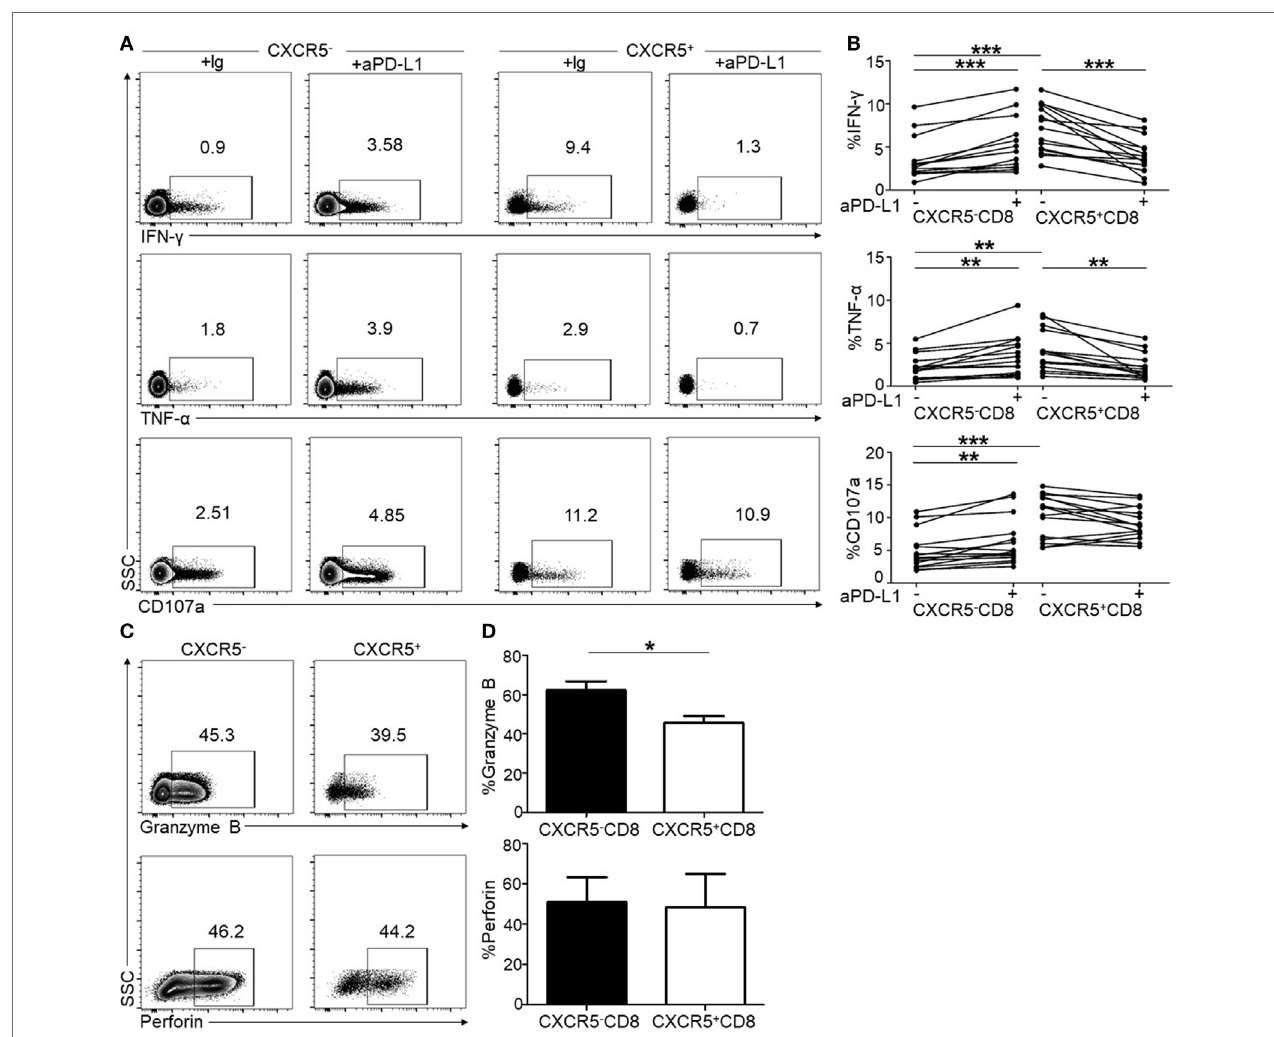
FigUre 4 | Programmed cell death 1 (PD-1) blockade shows opposite effects on CXCR5 − and CXCR5 + CD8 + T cells in peripheral lymphocytes. Peripheral blood mononuclear cells (PBMCs) from HIV-infected patients were stimulated for 8 h using HIV overlapping peptides with or without anti-PD-L1. The flow cytometric plots show intracellular IFN- γ (a) , TNF- α (a) , and CD107a (a) staining on CXCR5 − and CXCR5 + CD8 + T cells populations, respectively. (B) Statistical analysis of intracellular IFN- γ , TNF- α , and CD107a staining of CXCR5 − and CXCR5 + CD8 + T cells (a paired t- test was used, ** p < 0.01; *** p < 0.001). (c) The flow cytometric plots of intracellular granzyme B and perforin. (D) Statistical analysis of granzyme B and perforin staining of CXCR5 − and CXCR5 + CD8 + T cells (a paired t- test was used, * p <